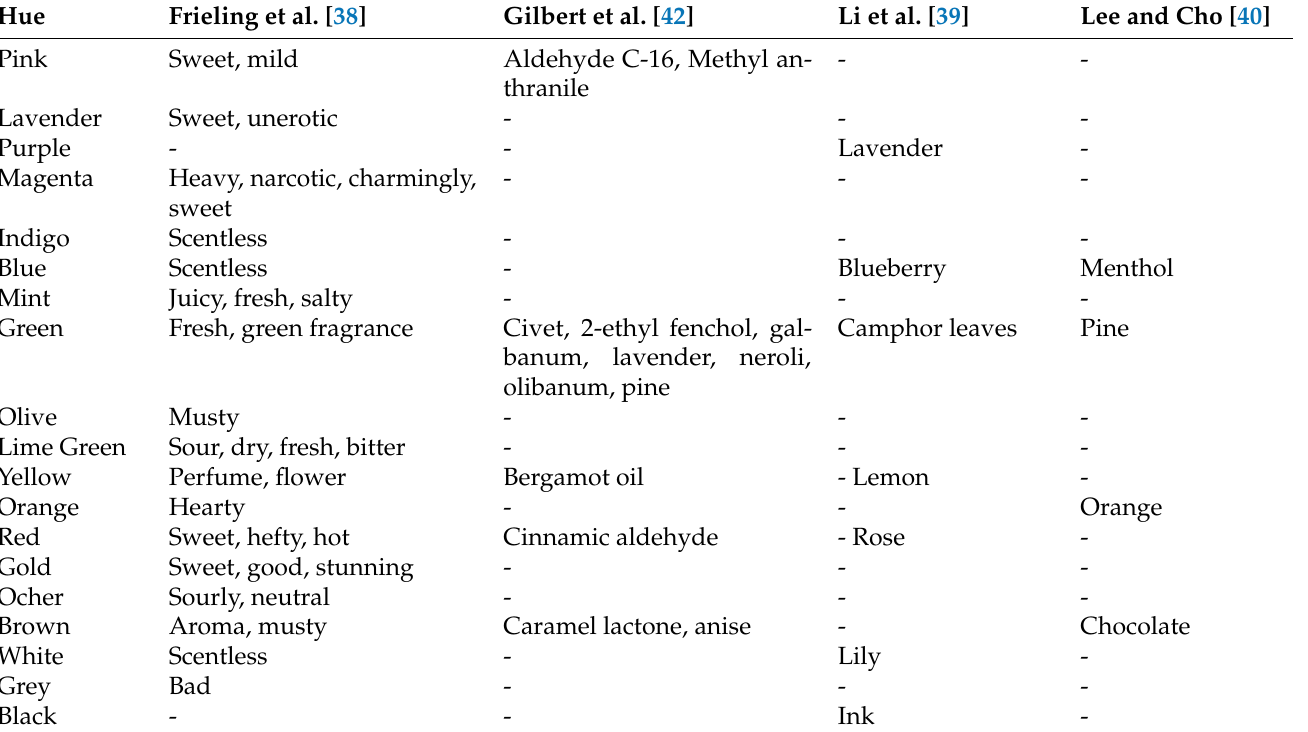
Table 3. Odor-hue color codes for olfactory representation of